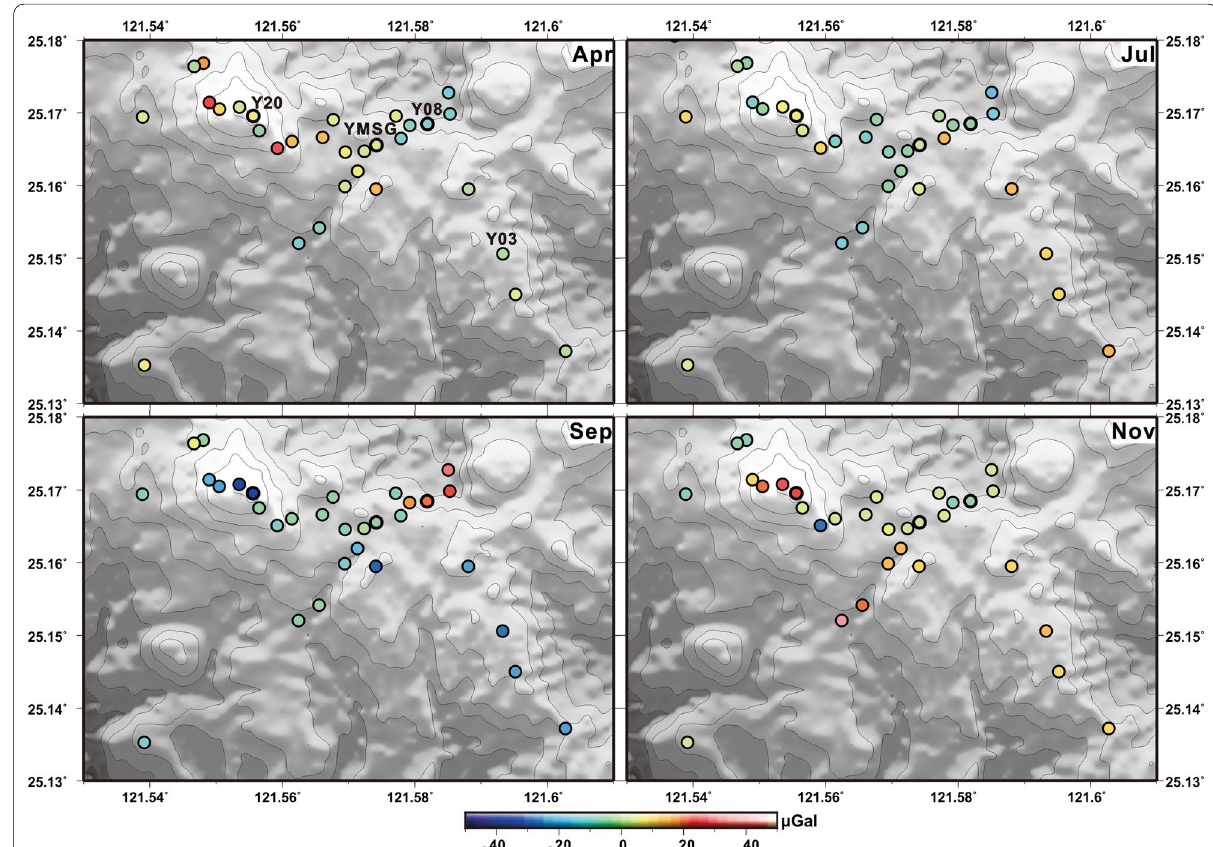
Fig. 2 The observed gravity changes in April, July, September, and November 2012. The stations Y20 (Chishinshan), YMSG (Chintiengang), Y08 (Dayoukeng), and Y03, at the different geological backgrounds, are